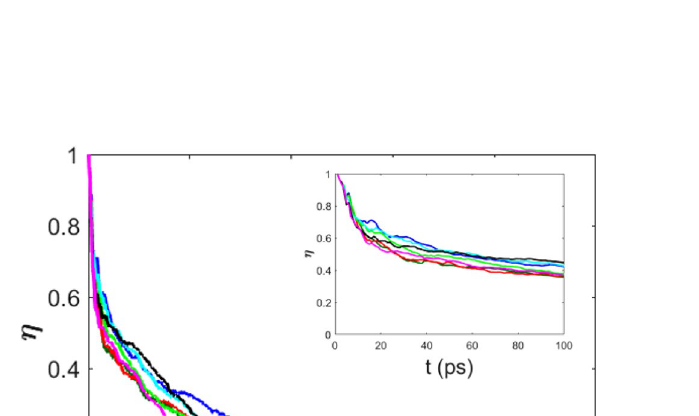
Figure 7. Decay of the electron energy for ( a ) ǫ 10 ( ǫ 65.8 meV); the other parameters are the same of Fig. 1, but χ and ( d ) ǫ ′ = = 13 measured in 10 − s; electron energy is given in eV.